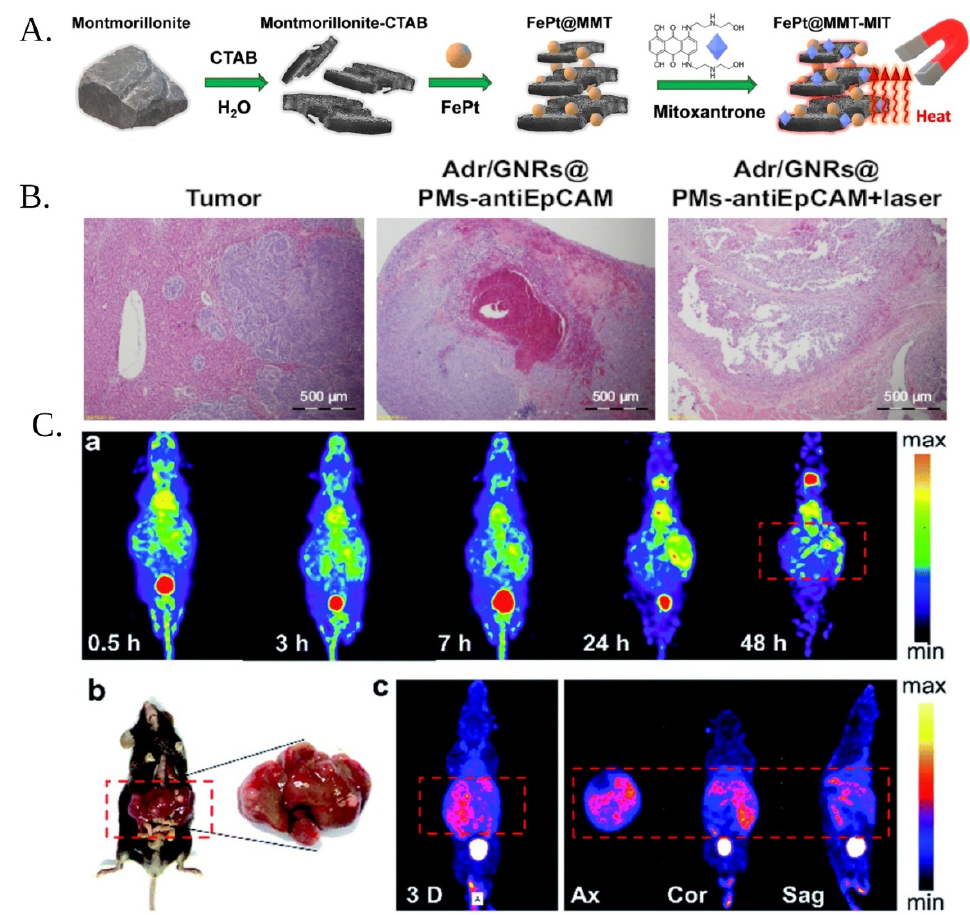
Figure 4. ( A ) Schematic representation of the synthesis of montmorillonite (MMT)-based nanoparticles for theragnostic applications. The MMT reacted with cetyltrimethylammonium bromide (CTAB), to form a layered structure in which iron-platinum nanoparticles and mitoxantrone were incorporated. The platform was used for magnetically induced hyperthermia (adapted from Reference [86] (Open access)). ( B ) Histology studies illustrating the anti-tumor of adryamicin-loaded, gold-nanorod polymeric nanomicelles modified with EpCAM antibody (Adr/GNR@PMs-antiEpCAM), and the same complex under laser irradiation (adapted from Reference [88] (Open Access)). ( C ) SPECT images of the radioactive iodide labeled Pd nanosheets at different time intervals in vivo ( a ) image of liver tissue and ( b ) SPECT images obtained using a conventional tracer used as control method ( c ) (adapted from Reference [89] (Open Access). Created with BioRender.com).